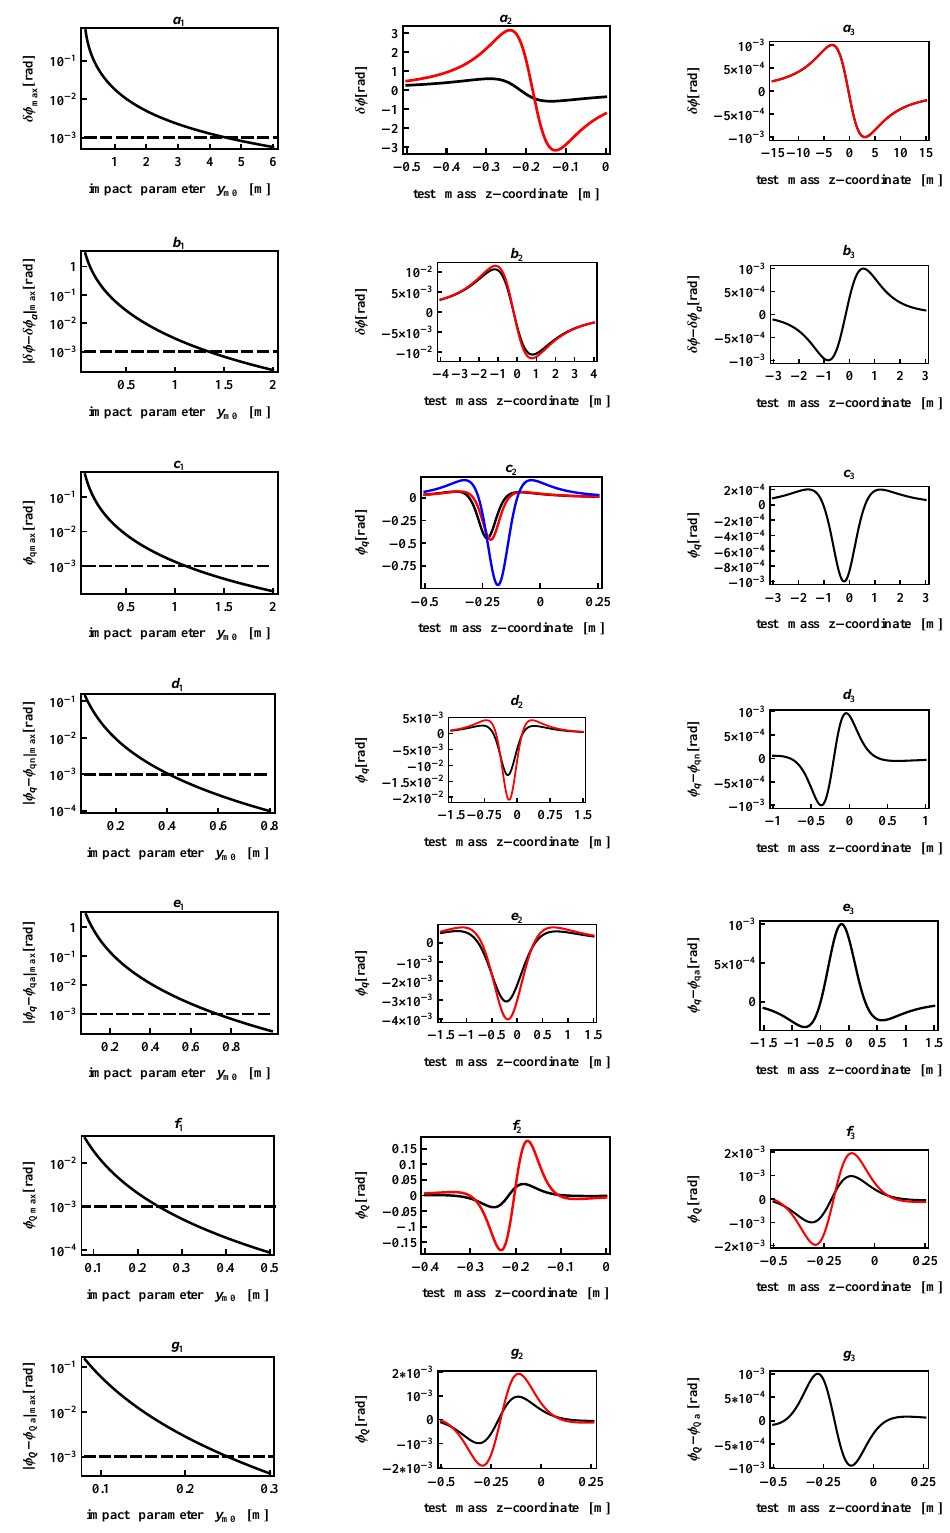
Figure 3. Test mass moving with constant velocity 5 m/s. Columns 1, 2 and 3 mirror Columns 1,3 and 4 of Figure 2. Values of { x m 0 , y m 0 } are {− 1.05 m, y min } for Plots a 2 , f 2 , {− 1.05 m,4.53 m } for Plot a {− 1.05,1.34 } for Plots b {− 1.13 m, y {− 1.22 m,1.11 m } } for Plot c 3 , 2 , min 2 , for Plot c 3 , {− 1.33 m,0.407 m } for Plot d 2 , {− 1.21 m,0.732 m } for Plot e 2 , {− 1.05 m,0.249 m } for Plot f 3 and {− 1.05 m,0.250 m } for Plot g 2